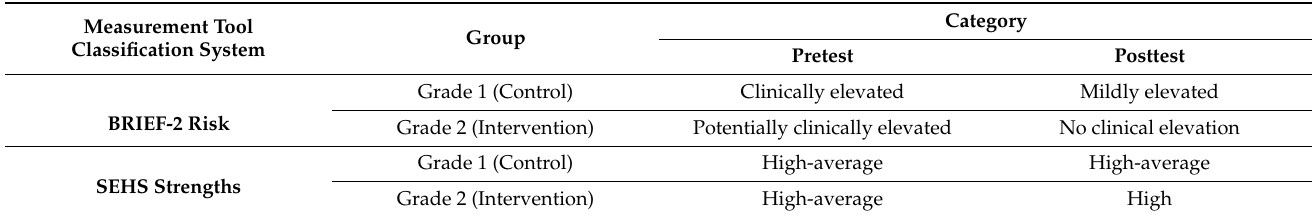
Table 6. Multidimensional group profiles measured over